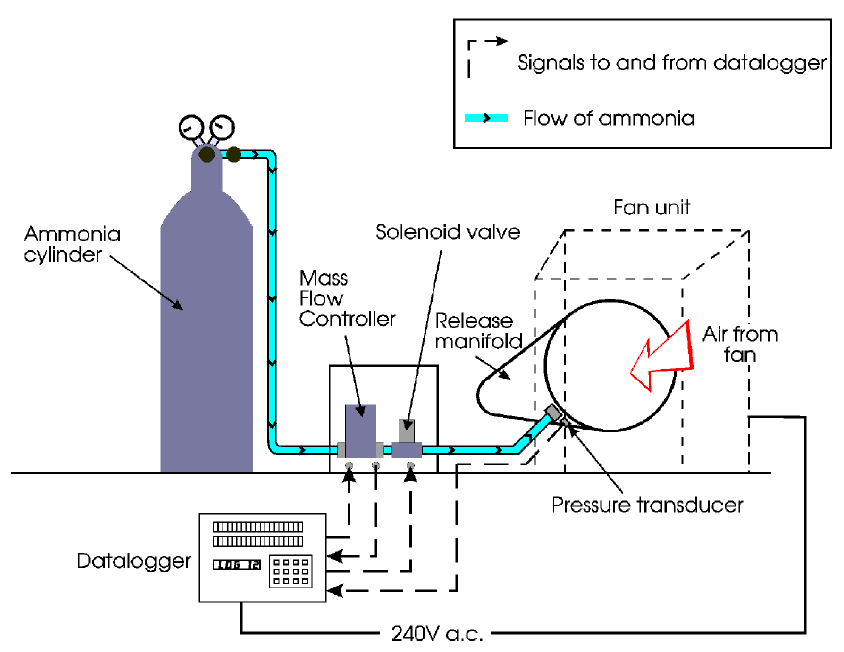
FIGURE 1. Diagram of the ammonia release and control